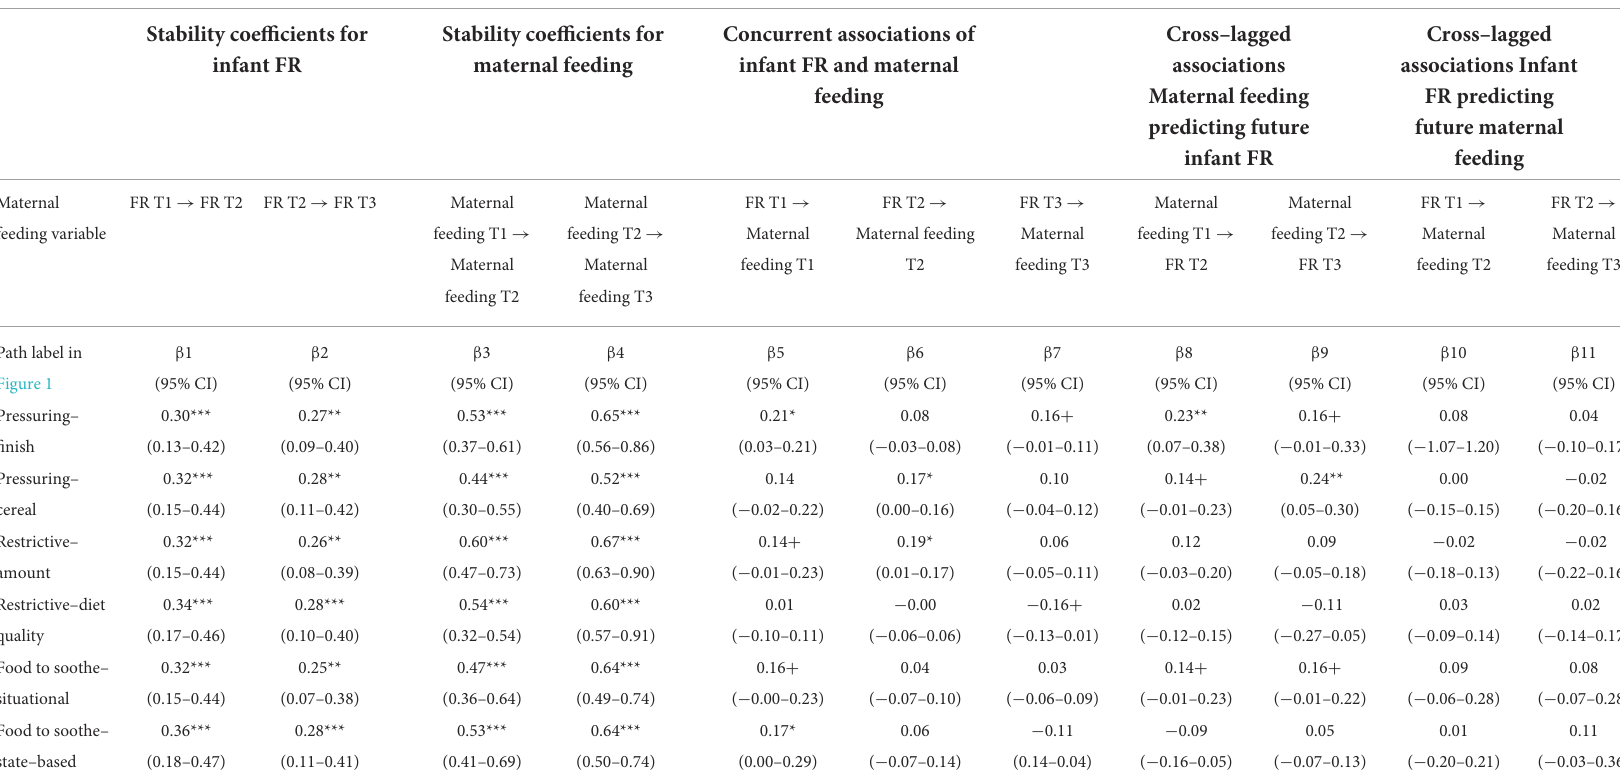
TABLE 2 Standardized path coefficients for model shown in Figure 1 ( N =